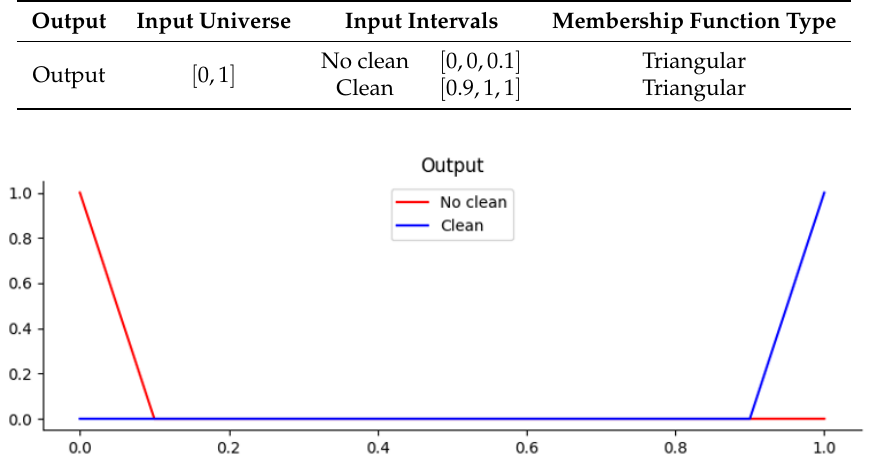
Table 9. Definitions of output membership functions.